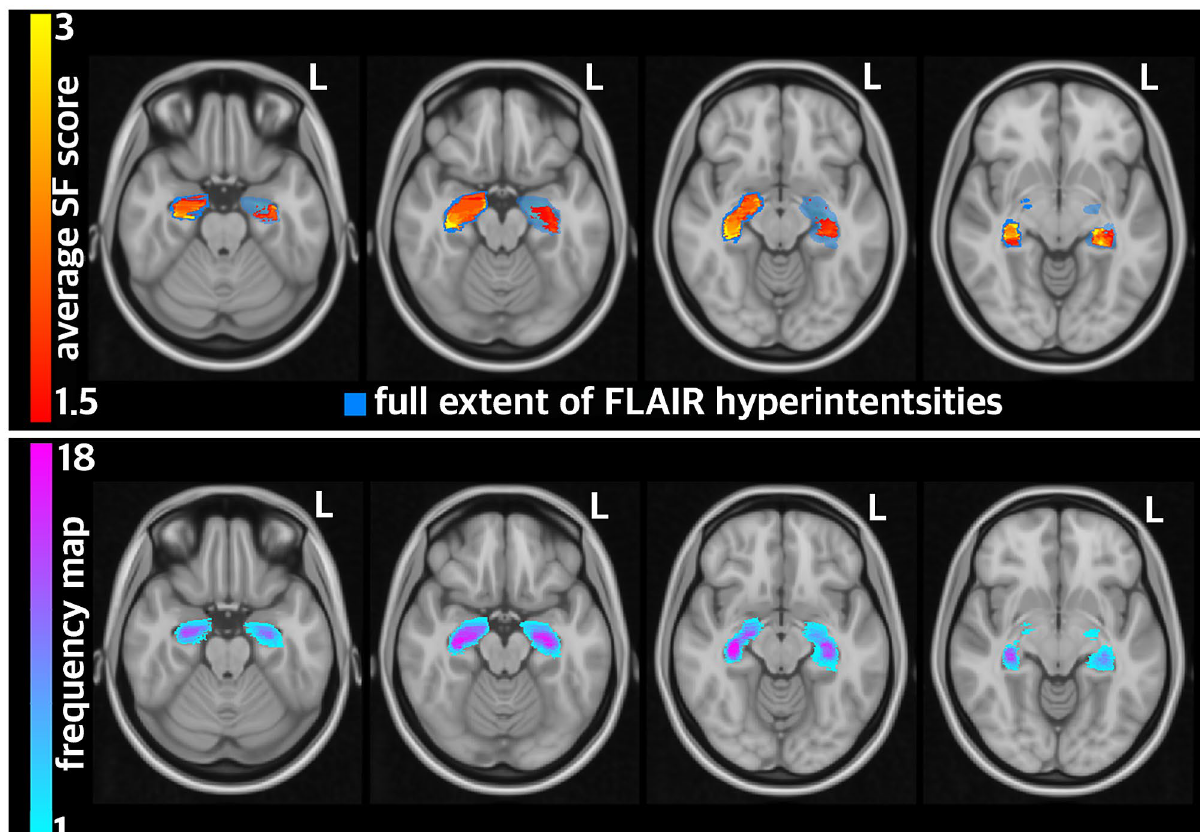
Figure 3. Probabilistic mapping of seizure risk using FLAIR signal hyperintensity regions. Areas of hyperintense FLAIR signal were segmented in each patient, transformed into a common brain (MNI152), and then weighted by their corresponding ccSFS score. The average risk of seizure based on the ccSFS score and FLAIR signal location was then computed at each voxel (warm colors). This probabilistic map of seizure risk (warm colors) is overlaid on maps showing the general distribution of the FLAIR signal across patients (i.e., summation of frequency maps, cool colors). For both sides, the highest risk of seizures was seen in the posterior